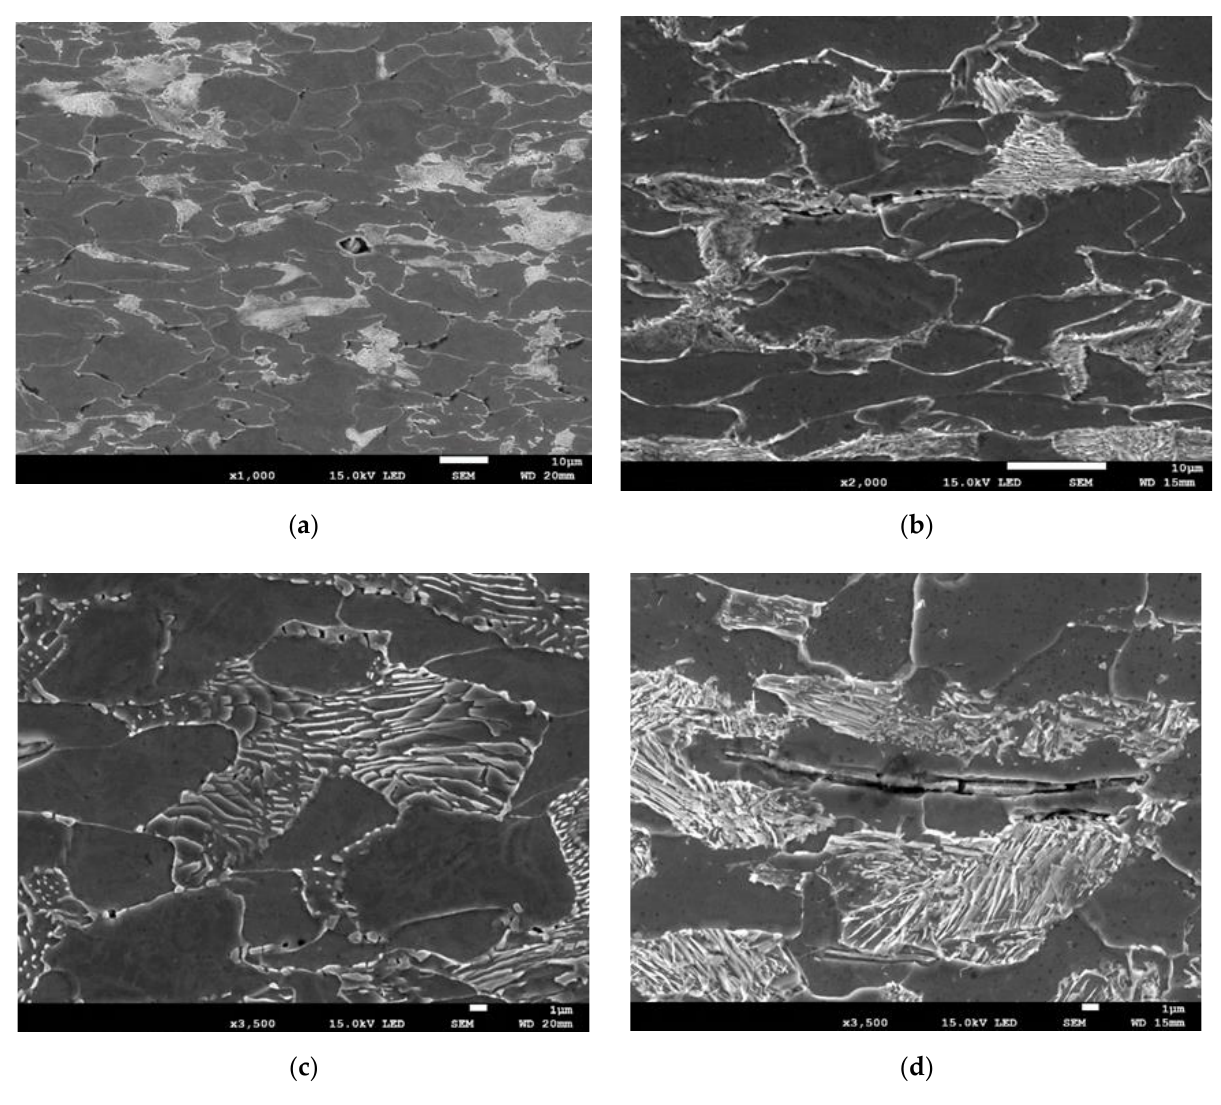
Figure 7. ( a – d ) Decohesion and fracture of MnS inclusions during the initial stage of neck for-